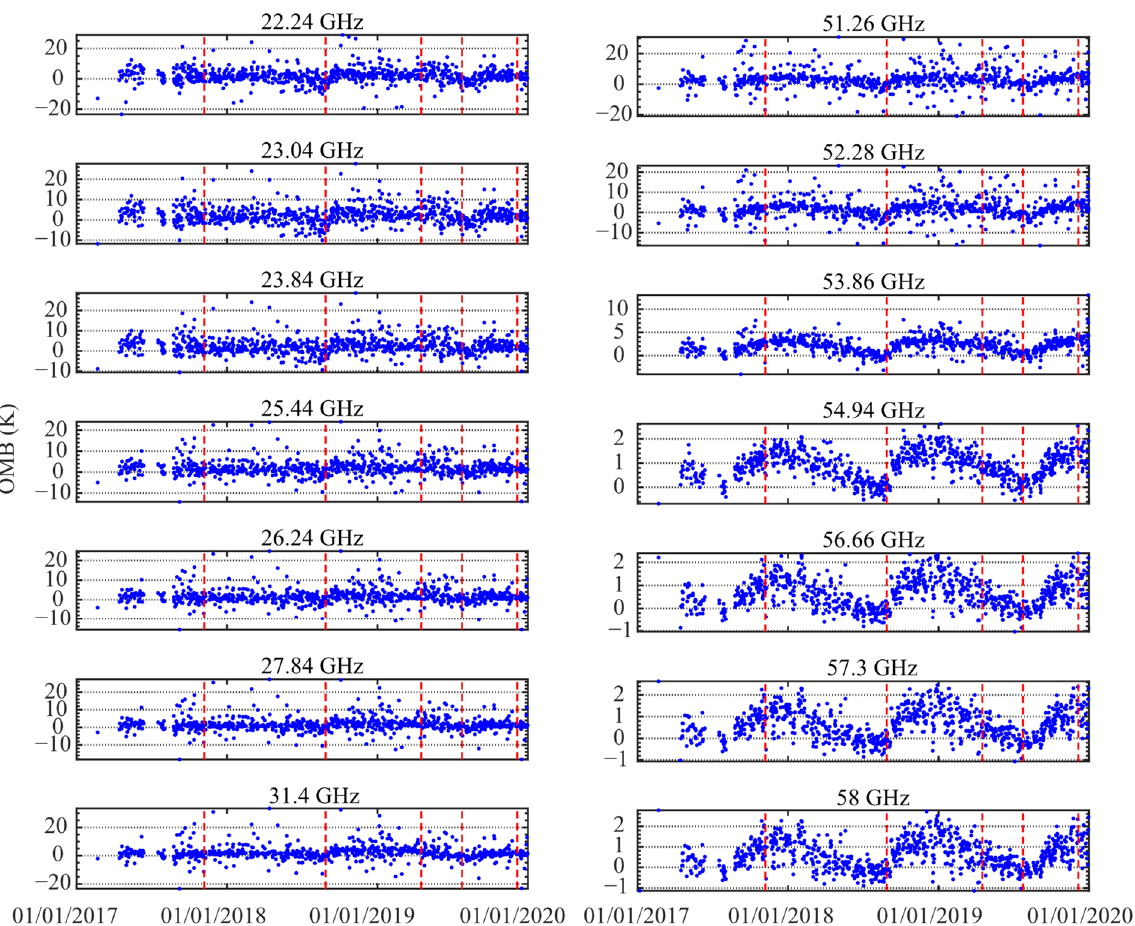
Figure 6. Time series diagrams of OMB (with CLW) of 14 channels in the no-precipitating cloudy weather (the red dashed lines are the dates of MWR calibration).